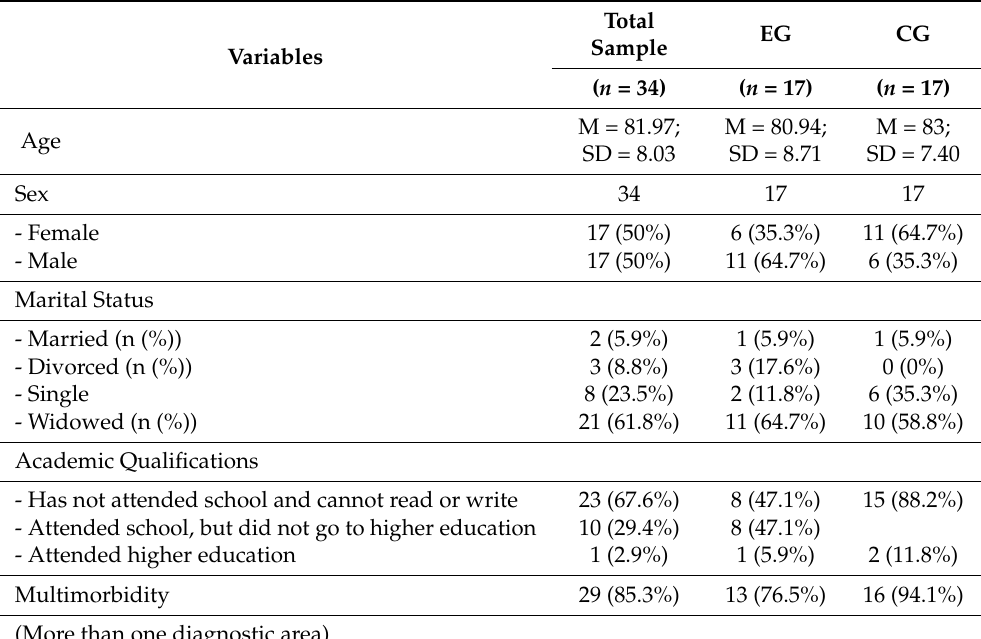
Table 1. Sociodemographic Characterization.